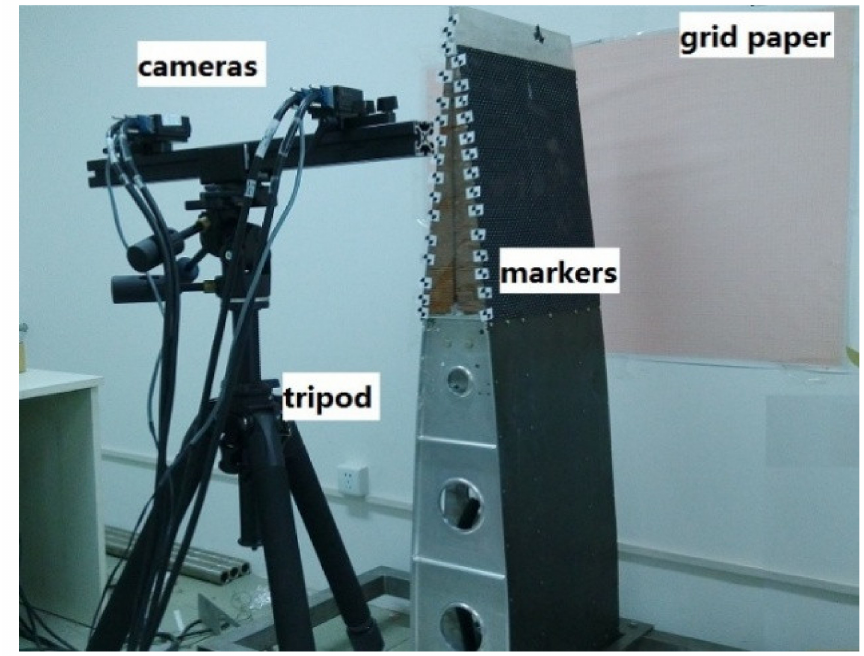
Figure 7. Binocular vision